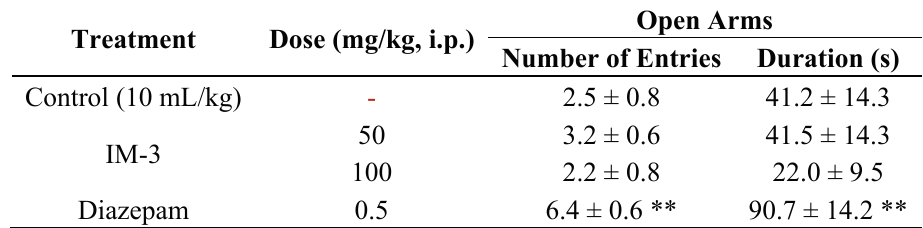
Table 2. Effect of IM-3 on the elevated plus-maze test in mice.